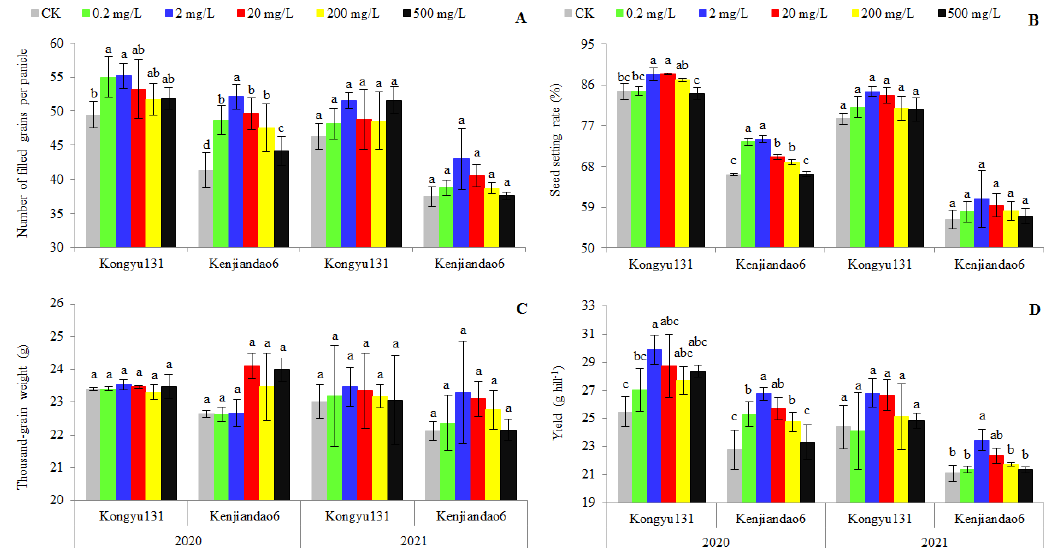
Figure 3. The changes in yield components and yield in both cultivars treated with diethylaminoethyl hexanoate (DA-6) under cold water stress (CWS) at booting in 2020 and 2021. The letters above the columns indicate significant differences ( p < 0.05). ( A ) Number of filled grains per panicle, ( B ) Seed setting rate, ( C ) Thougand-grain weight, ( D ) Yield.